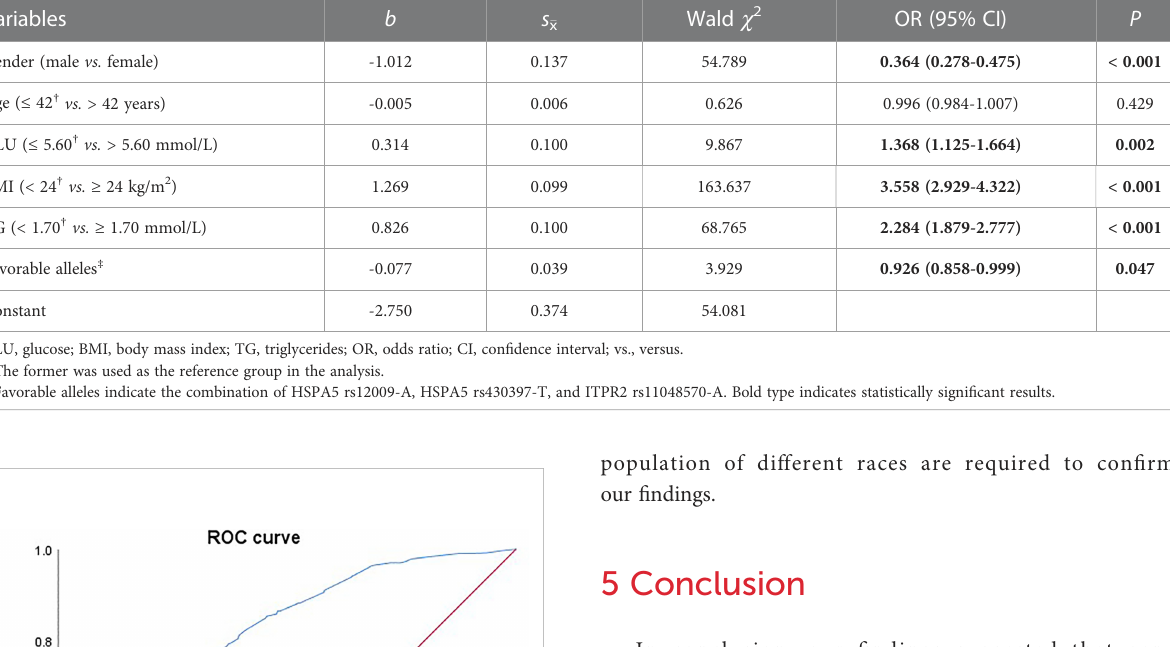
TABLE 5 Multivariate stepwise regression analysis for independent factors of NAFLD. Variables